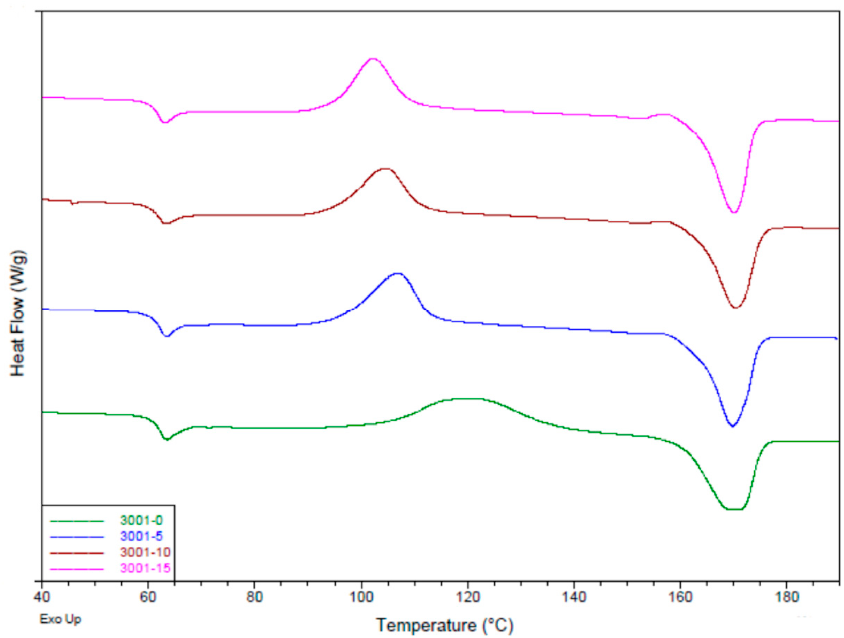
Figure 5. DSC scanning of PLA3001 and 3001 enriched with DE. Table 2. DSC results for the PLA and the PLA–DE composites.